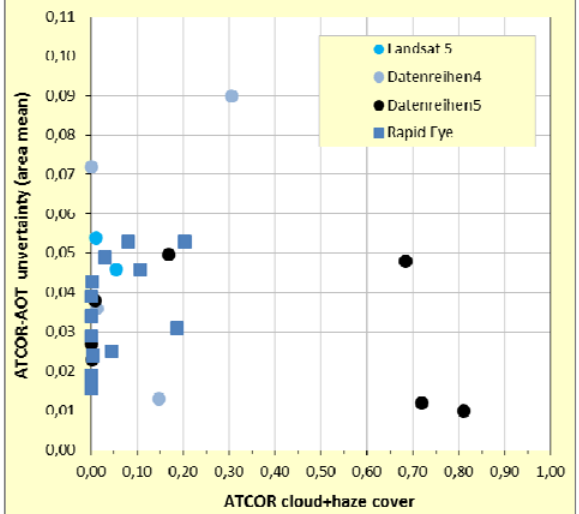
Figure 8. ATCOR-AOT estimation difference to ground-truth values as function of cloudiness .